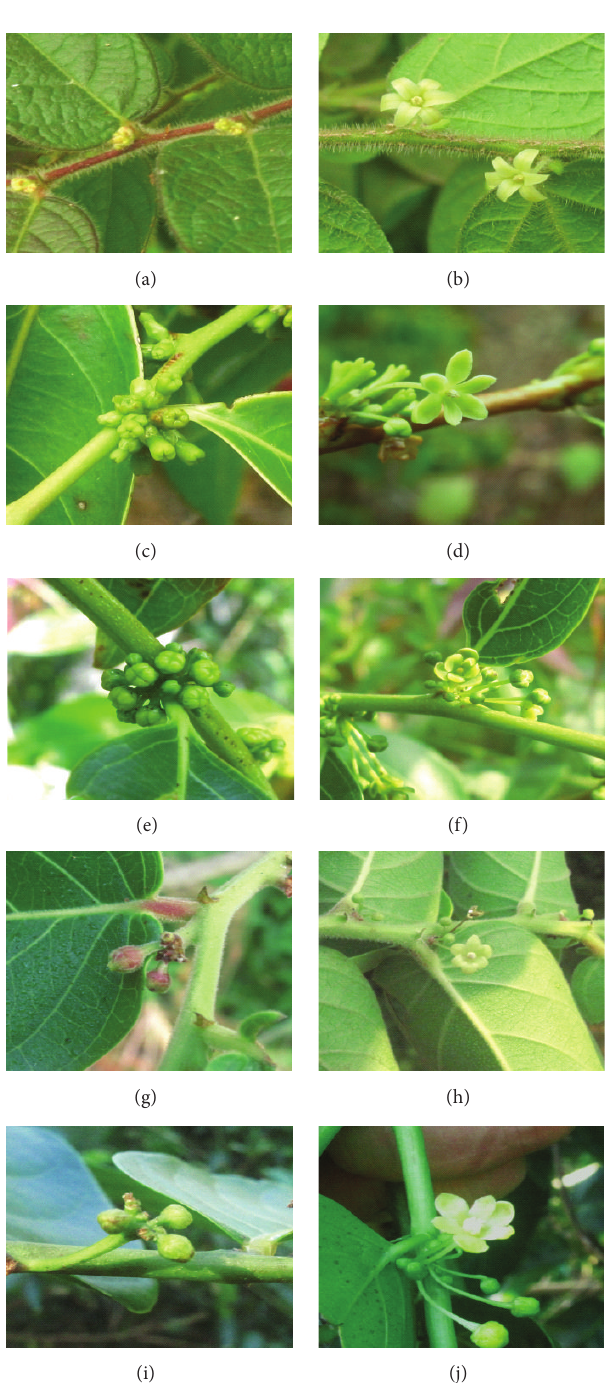
Figure 2: Flowers of the five Glochidion species in this study. Female of G . eriocarpum (a), G . daltonii (c), G . sphaerogynum (e), G. hirsutum (g), and G. zeylanicum (i). Male flowers of G . eriocarpum (b), G . daltonii (d), G . sphaerogynum (f), G. hirsutum (h), and G. zeylanicum (j).